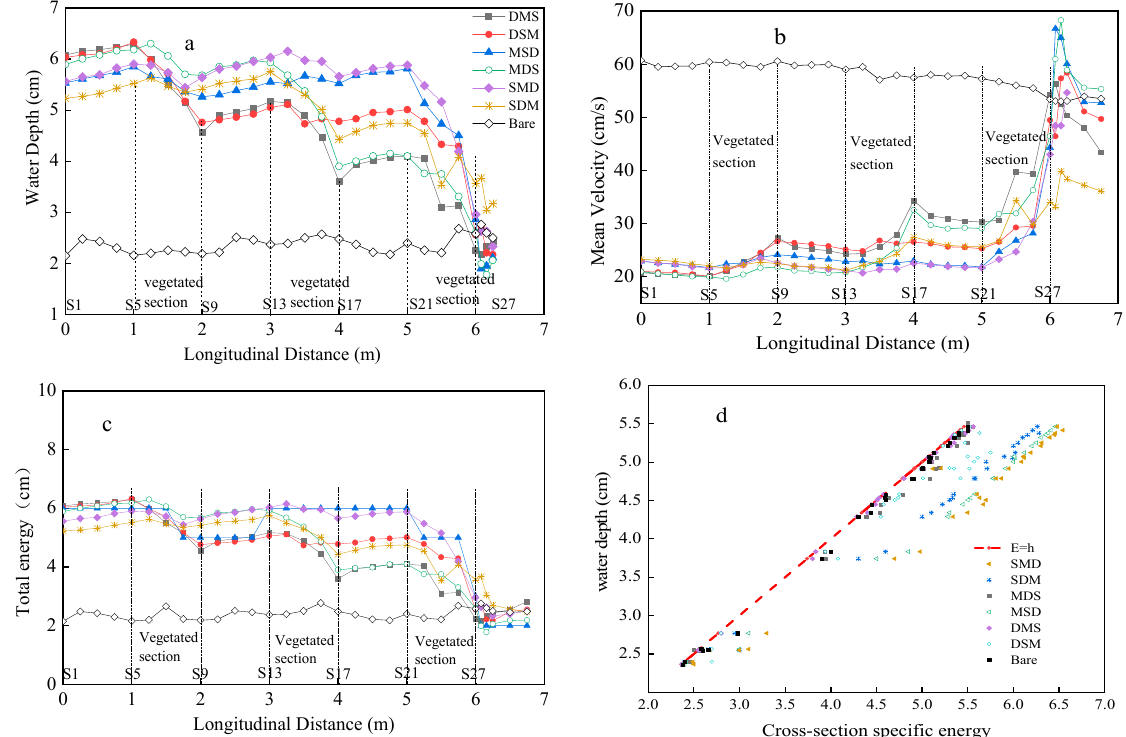
Figure 6. Longitudinal variations in the ( a ) water depth, ( b ) mean velocity, and ( c ) total energy in the longitudinal direction, and ( d ) relationships between the cross-section-specific energy and water depth for all vegetation configurations.